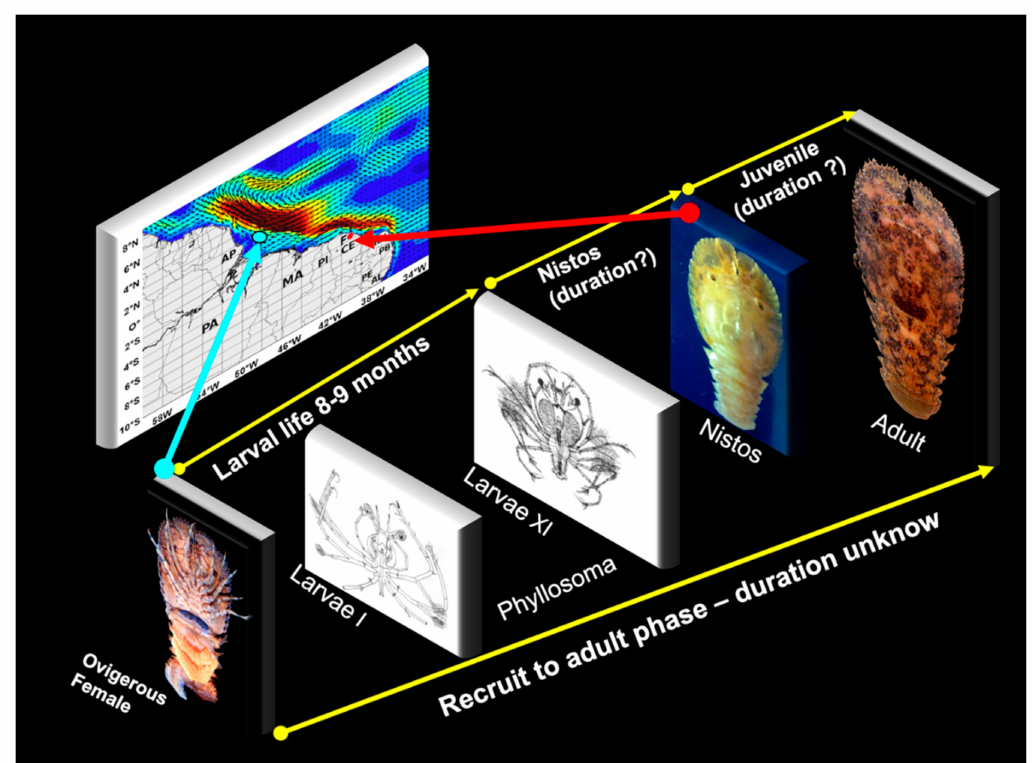
Figure 8. Theoretical scheme of life cycle of Parribacus antarcticus (Lund, 1793). Left: female carrying black spermatophores. Phyllosoma stages I to XI. Duration of the nistos and juvenile stages is unknown. Larvae and adults look alike. Map shows direction (arrow), intensity (color) and formation of retroflection eddies in North Brazil Current (Adapted from Cruz, et al. [8]). Light blue and red dot indicate locations in Great Amazon Reef System (GARS) and off Flecheiras (39 ◦ 13.5 (cid:48) W 3 ◦ 14.5 (cid:48) S) where ovigerous females and nistos were sampled,